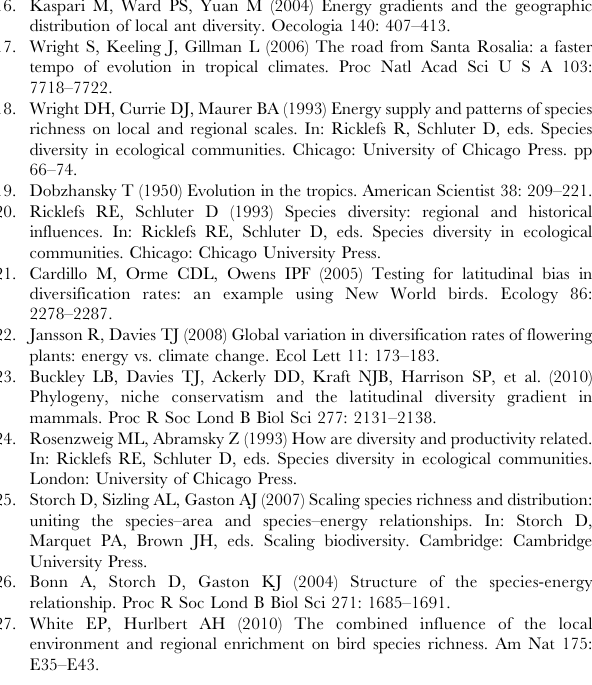
Table S13 Prediction success of bioregion-level models of Total and Resident richness of 110 km grid cell assemblages ( N = 9,253) based on mixed effects models. Grid cell richness is first fitted by the predictions for Resident species richness (‘‘[Bioregion] Predicted richness,’’ see Table 1) and then additionally by bioregion Area , and grid-cell-level relative productivity ( CellPropProductivity ). Bior- egion is fitted as a random effect, and the slope and strength of ‘‘[Bioregion] Predicted richness’’ and ‘‘[Bioregion] Predicted richness + Area ’’ as fixed effects are assessed. Pseudo- r 2 values of observed versus fitted are listed. The additional effect of grid cell productivity was evaluated by fitting it as additional fixed effect with a globally constant slope ( CellPropProductivity ) and by allowing the relationship with richness to vary within regions as a random slope ( CellPropProductivity var